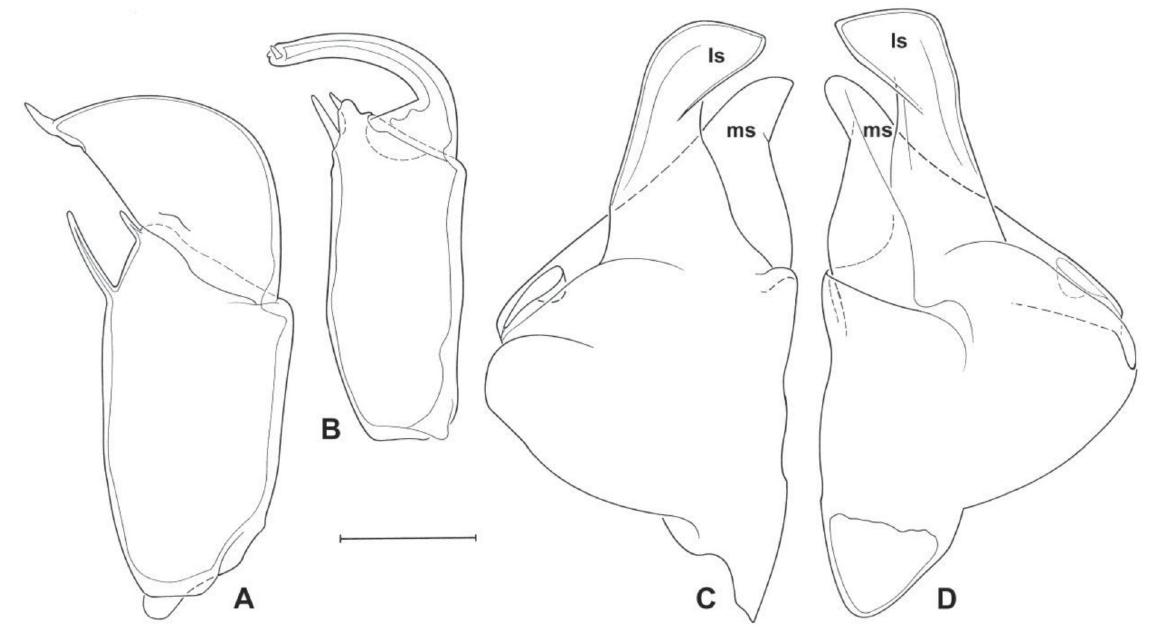
Fig. 8. Bennelongia regina sp. nov. (all from holotype ♂ = W40060). A . Right prehensile palp. B . Left prehensile palp. C . Hemipenis. D . Outline of other hemipenis. Scales: A-B = 89.3 μm, C-D = 104.2